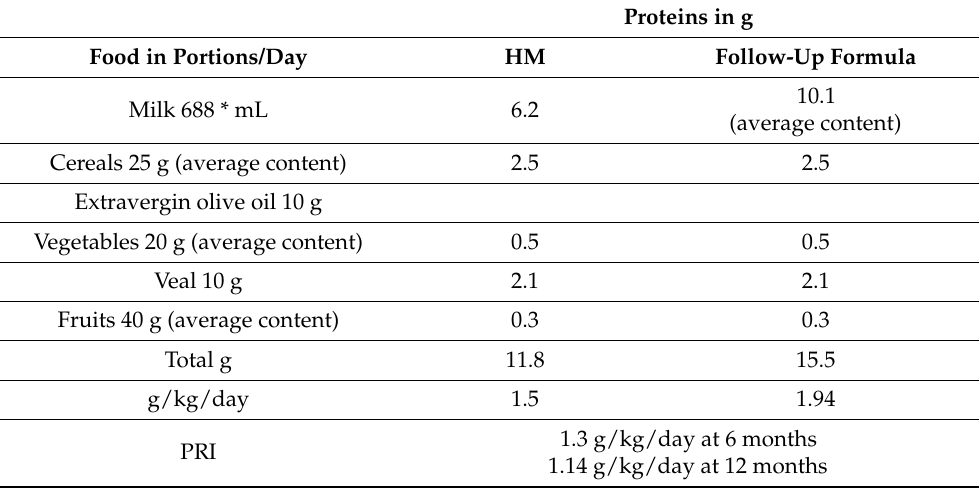
Table 2. Different protein intake for a 6–8-month-old infant when breastfed or formula-fed, with a single solid food intake scheme, assuming a body weight between 7.3 and 8.6 kg [32] and a PRI for protein of 1.3 g/kg/day [35]. The amount of milk * is defined according to Dewey’s observational data [7].